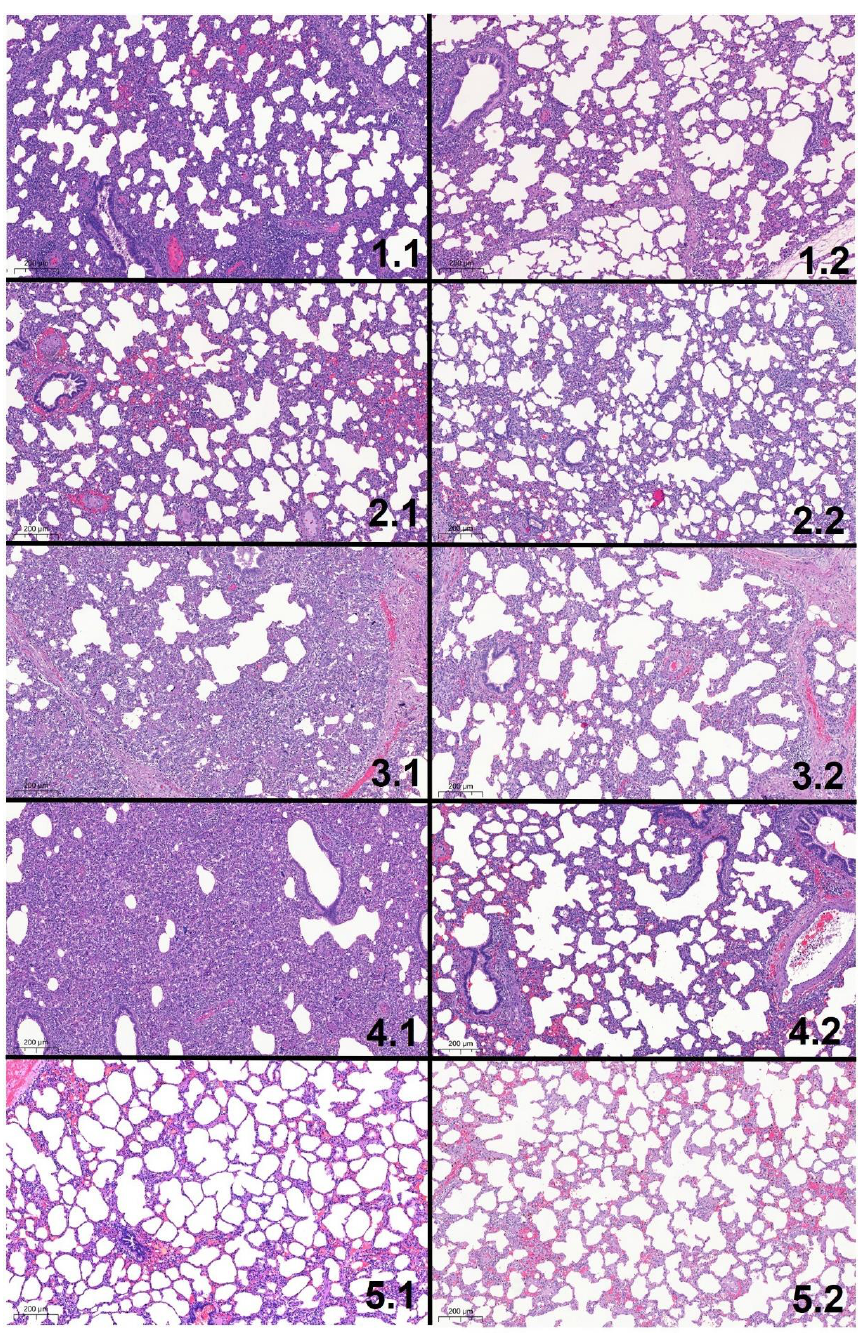
Figure 11. Representative histologic pictures of lung tissues obtained from the different groups at both necropsy time points (1: 14dpi; 2: 42dpi). The numbers indicate the groups according to Table 1 and the necropsy time point (group.necropsy time point). The most severe lesions are seen in the non-vaccinated groups (3 and 4) with severe interstitial pneumonia and massive alveolar necrosis. The lesions are milder and no longer statistically significant between the groups at the second necropsy time point. Histologic scores of the five lesions (pneumocytic hypertrophy and hyperplasia, septal infiltration with mononuclear cells, intra-alveolar necrotic debris, intra-alveolar inflammatory cell accumulation, and perivascular inflammatory cell accumulation for severity (0: no lesion; 1: mild; 2: moderate; or 3: severe) and extension (0: not present; 1: focal; 2: multifocal; 3: diffuse distribution) for the lung lobes) were: 1.1: 19/30; 2.1: 18/30; 3.1: 22/30; 4.1: 25/30; 5.1: 2/30; 1.2: 11/30; 2.2: 10/30; 3.2: 12/30; 4.2: 9/30; 5.2: